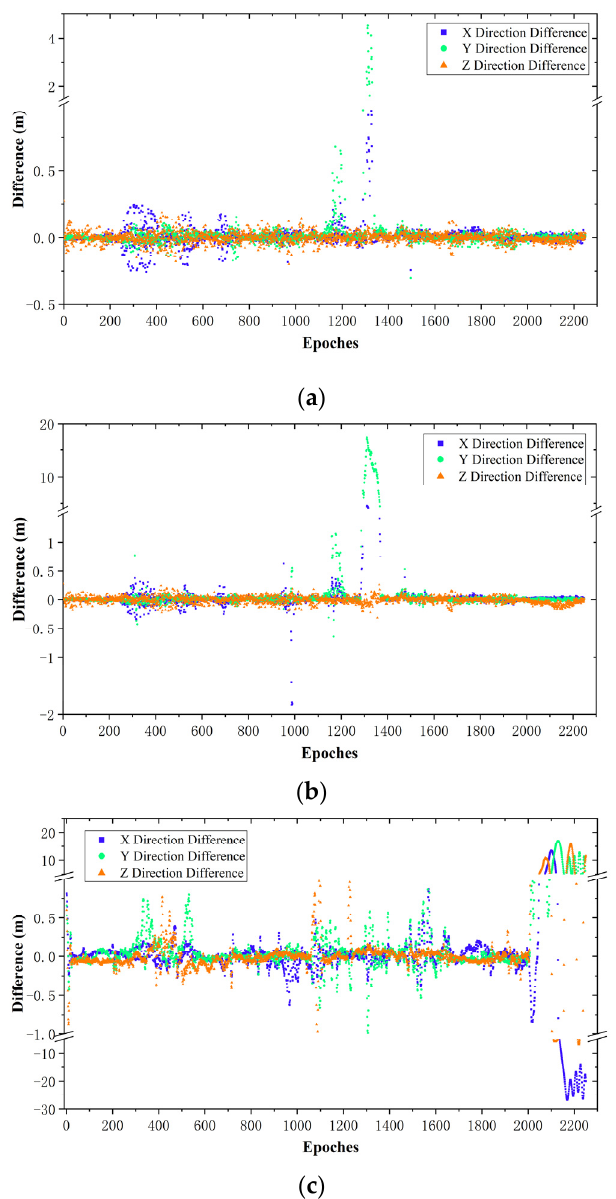
Figure 12. ( a ) Difference between trajectory Traj_A and Traj_B; ( b ) Difference between trajectory Traj_A and Traj_C; ( c ) Difference between trajectory Traj_A and Traj_NDT. The statistical average time cost of scan-to-map matching is shown in Table 9. It